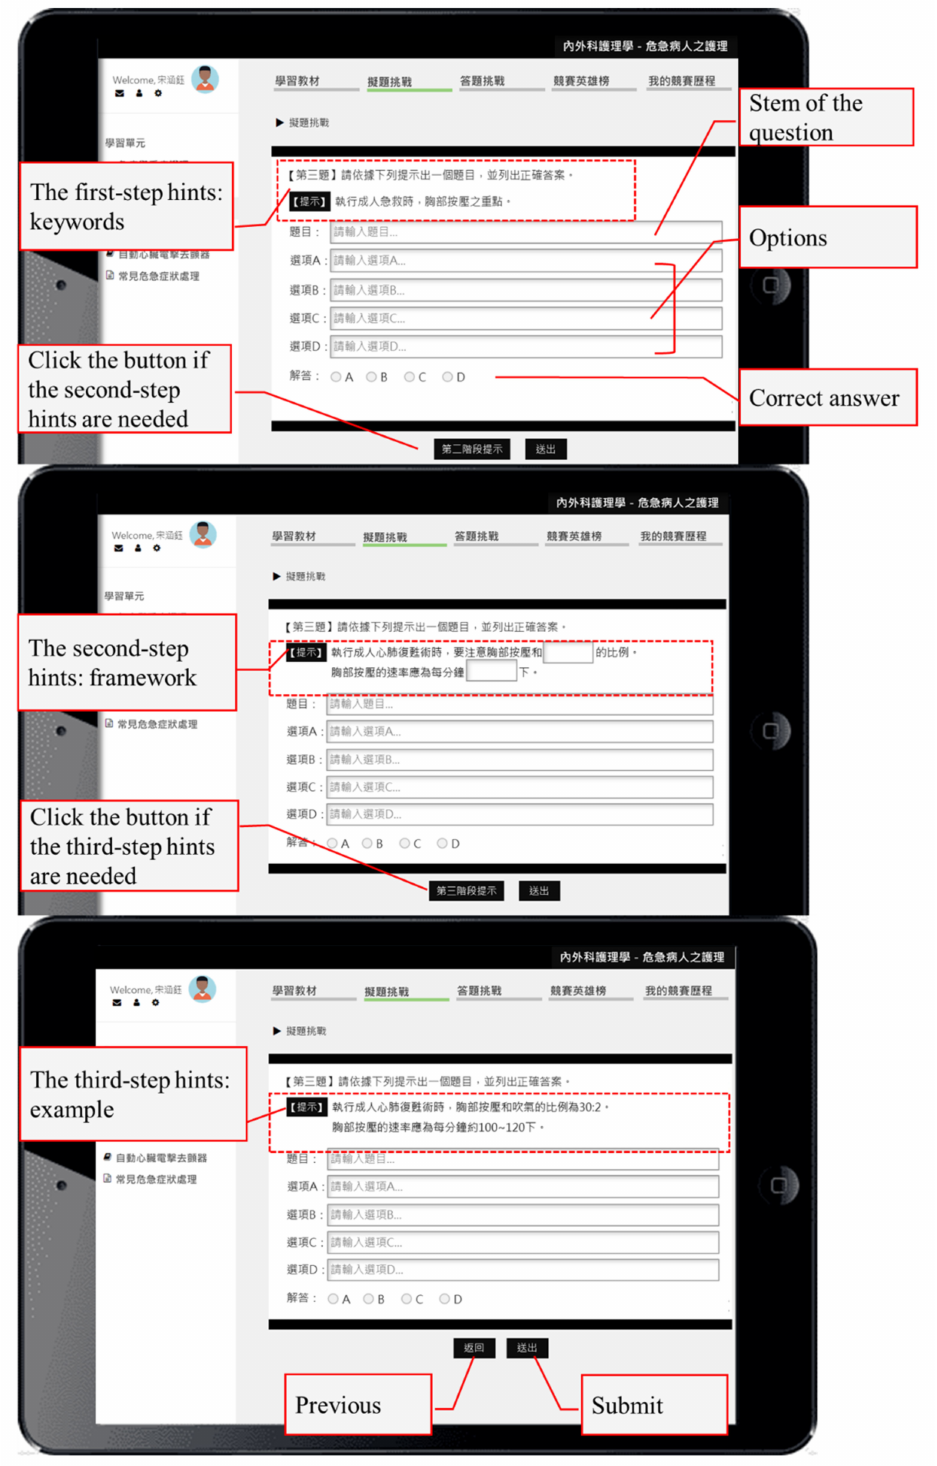
Figure 3. Three-step problem-posing-based learning